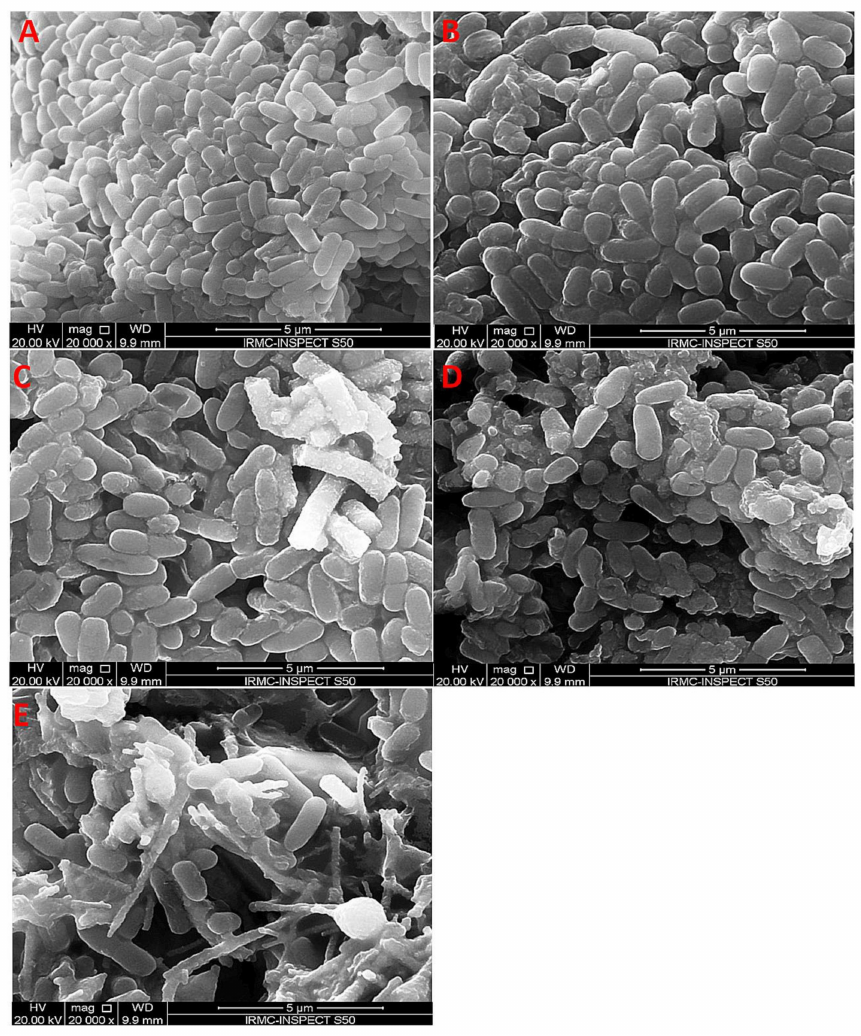
Figure 6. Effect of electrospun TiO 2 NPs on the morphological aspects of P. aeruginosa as examined by scanning electron microscopy: ( A ) control without any treatment and treated with TiO 2 calcined in ( B ) 100% Air, ( C ) 50% Air, and 50% Argon, ( D ) 25% Air and 75% Argon; and ( E ) 100% Argon. Reproduced from Ref.